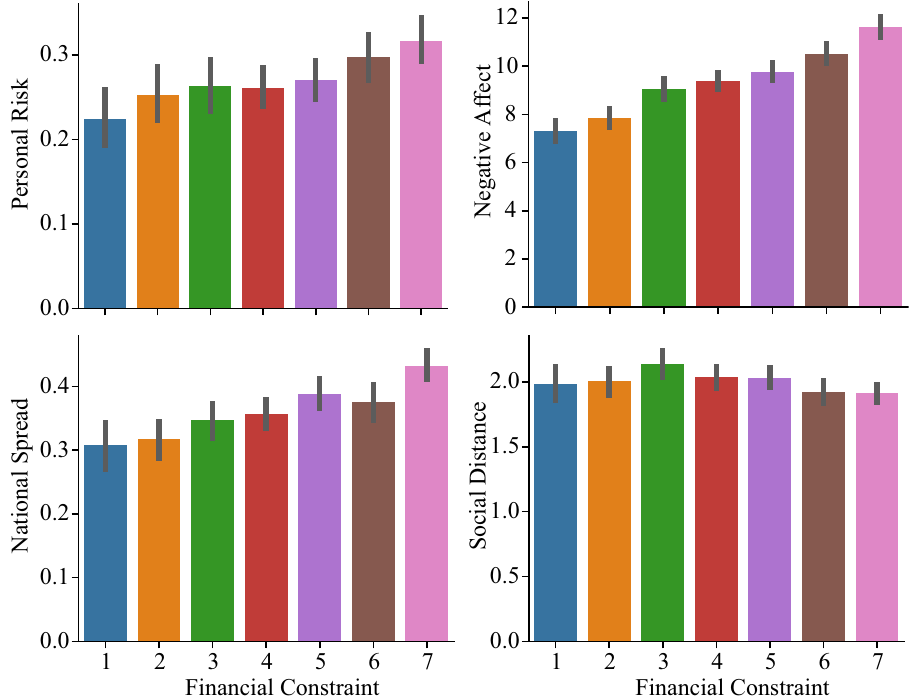
Figure 2. Relationship between financial constraint and key variables of interest. Top left: relationship between financial constraint and beliefs about one’s risk of contracting COVID-19. Top right: relationship between financial constraint and negative affect, measured using the short-form of the PANAS. Bottom left: relationship between financial constraint and beliefs about the national spread of COVID-19. Bottom right: relationship between financial constraint and social distancing behavior, where smaller values on the social distancing variable indicted increased social distancing behavior. Error bars show the 95% confidence interval.